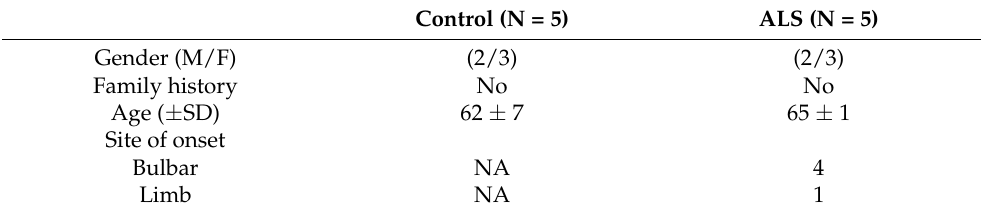
Table 2. Demographic and clinical characteristics of subjects included in this